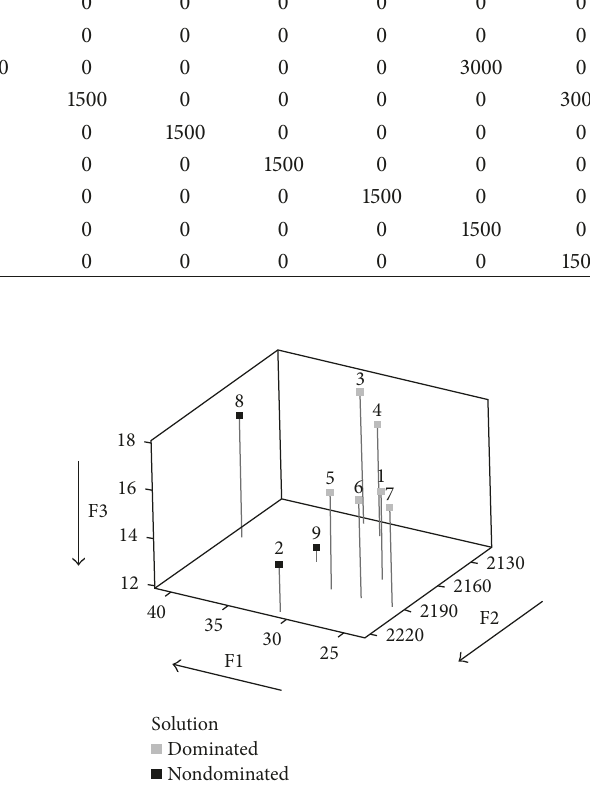
Figure 4: Graphical representation of the results of the solution set evaluated at 7 days (rotated